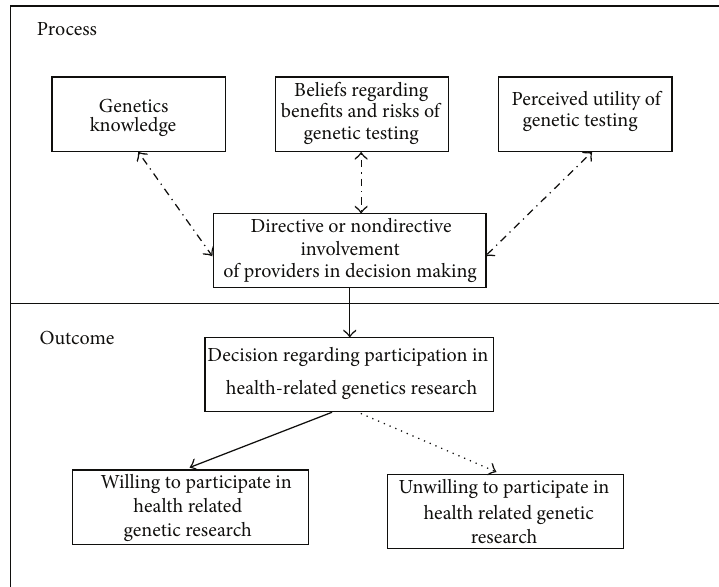
Figure 2: Organizing